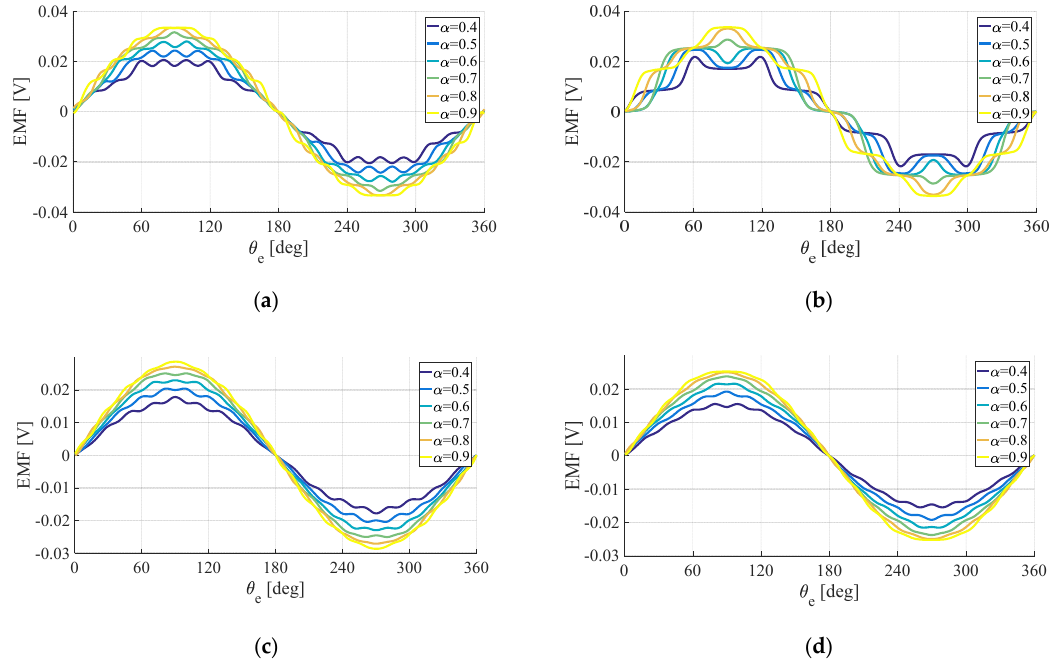
Figure 5. Line to line back-emf of 8 poles ( a ), 12 poles ( b ), 14 poles ( c ) and 16 poles ( d ) rotors.